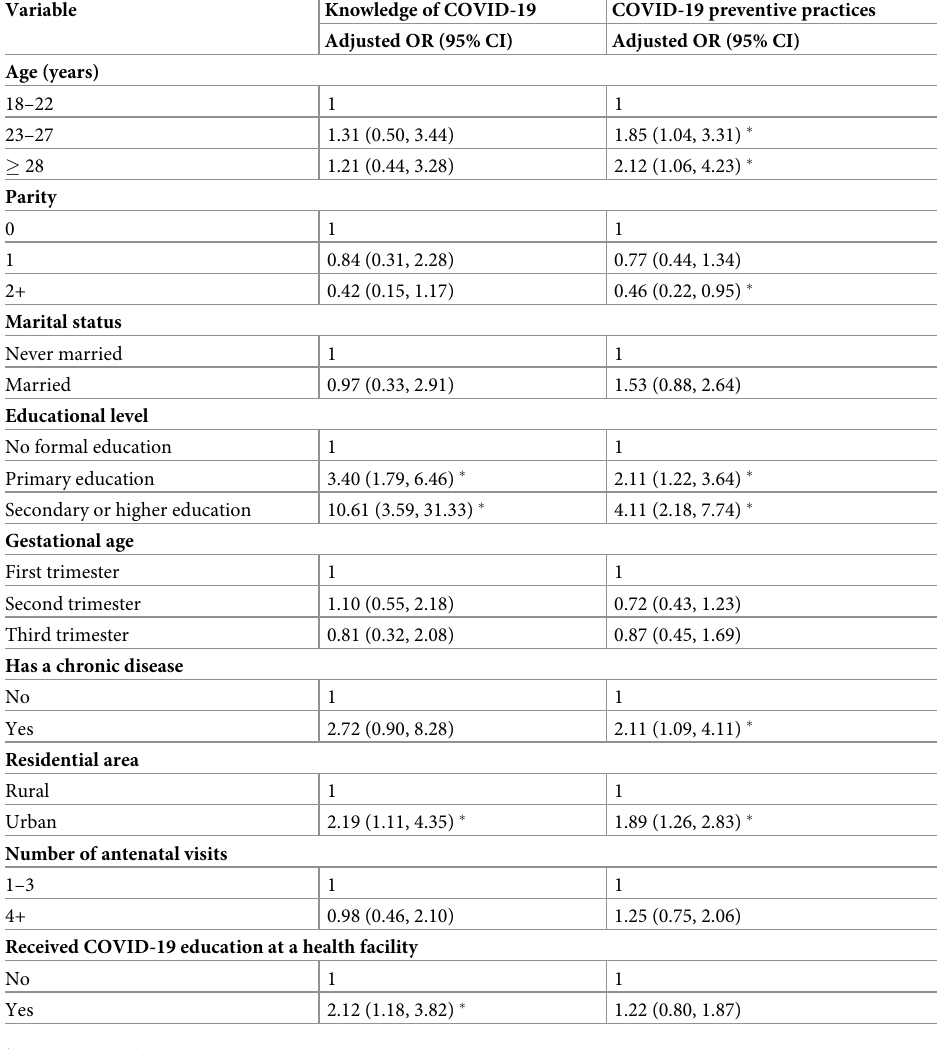
Table 2. Factors associated with knowledge on COVID-19 and practice of COVID-19 preventive